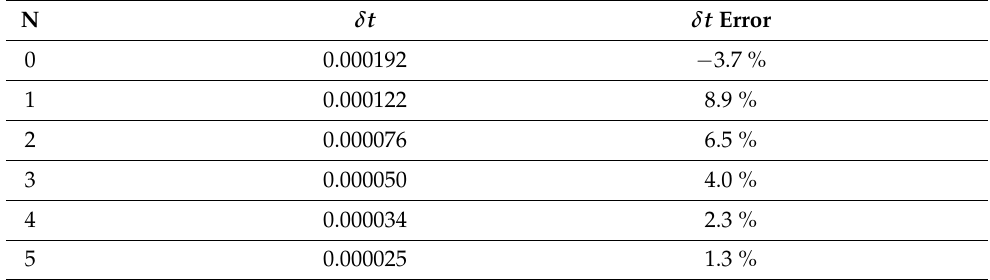
Table 4. Inner time step size δ t and relative δ t error for varying N , constant CFL number CFL ≈ 0.7 and ∆ x =